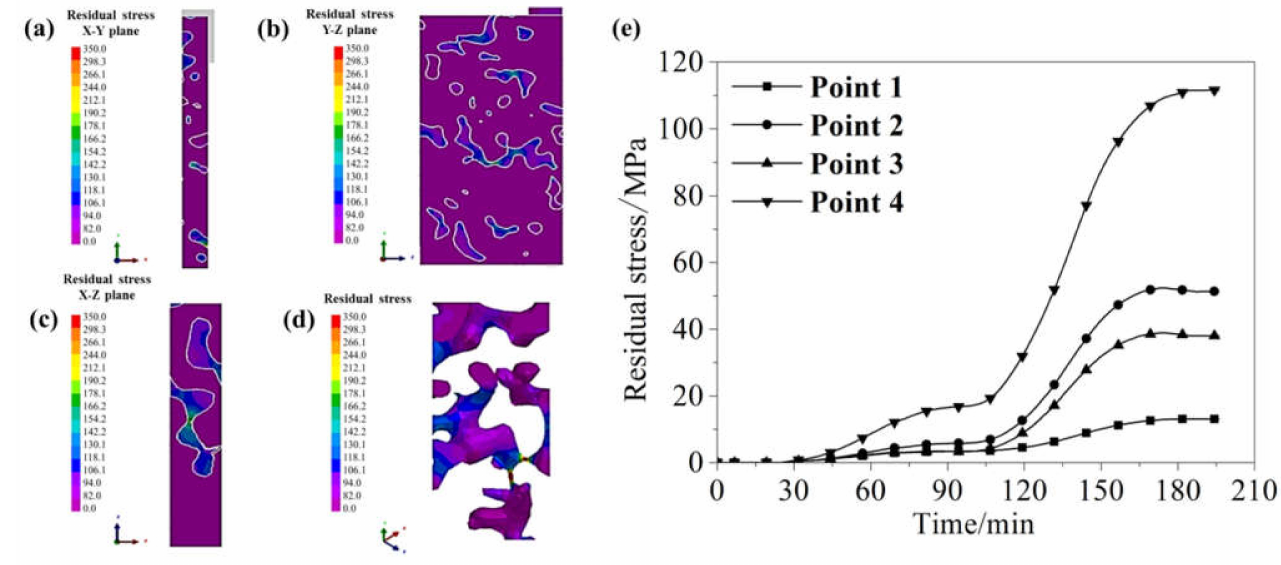
Figure 6. Residual stress distribution of SiC/Al composite: ( a ) X–Y plane; ( b ) Y–Z plane; ( c ) X–Z plane; ( d ) fine parts; ( e ) residual stress of the selected four